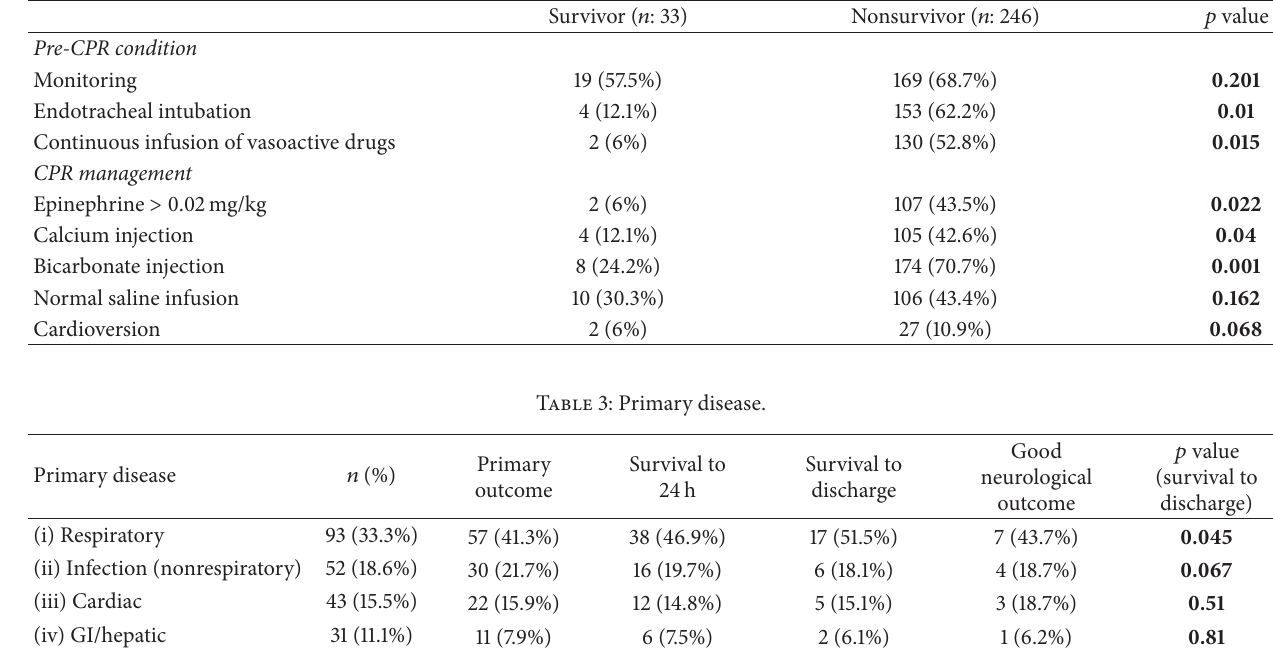
Table 2: Pre- and intraresuscitation conditions.